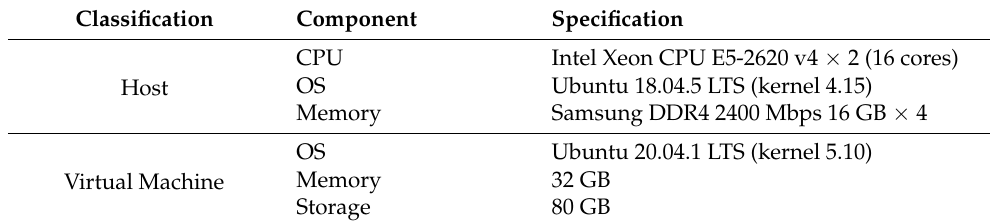
Table 1. Host and Virtual Machine Specifications.